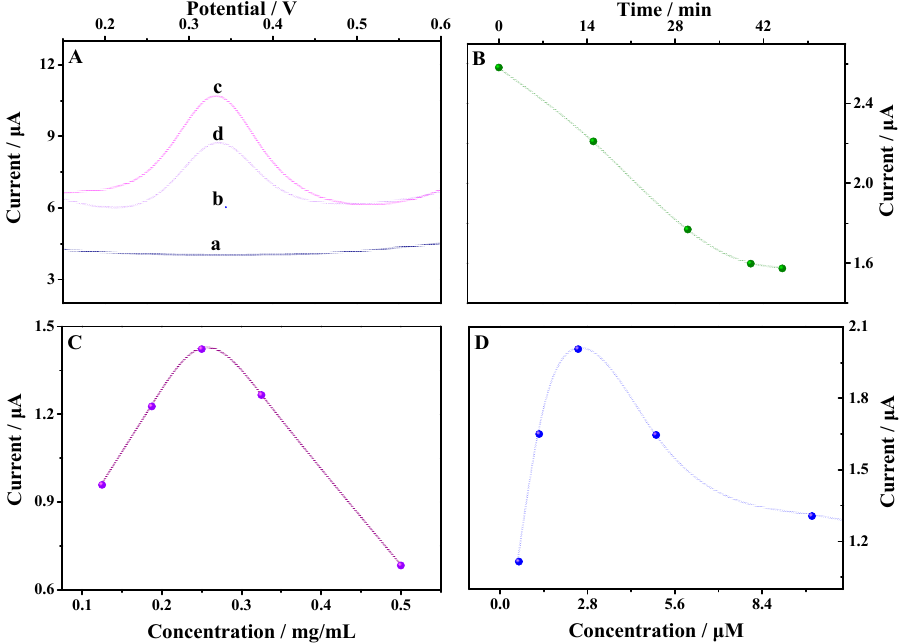
Figure 5. ( A ) Differential pulse voltammetry (DPV) of the bare electrode (curve a), TCPP–Gr/AuNPs/GCE (curve b), MbBA–Fc/TCPP–Gr/AuNPs/GCE (curve c), and MbBA–Fc/TCPP–Gr/AuNPs/GCE in 4.4 × 10 − 7 M myoglobin solution (curve d); ( B ) The relationship between the peak current and